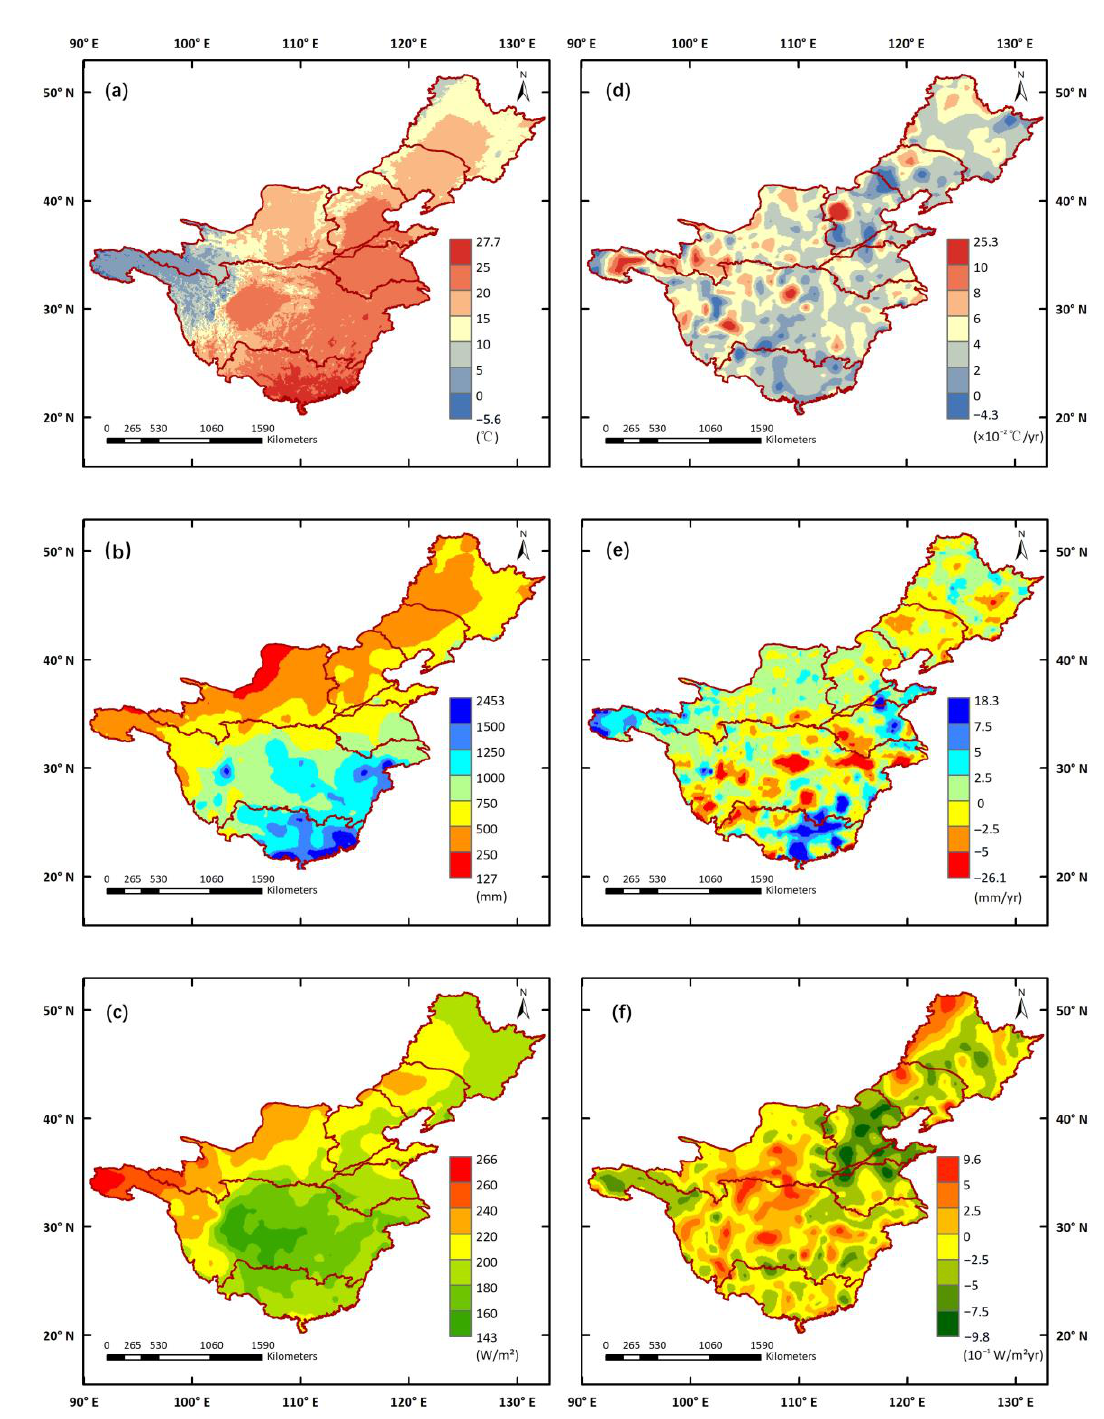
Figure 7. The spatial distribution of climate variables in seven major watersheds during 1982 – 2015: ( a ) mean annual GS-TEM, ( b ) mean annual GS-PRE, ( c ) mean annual GS-RAD, and their change trends ( d – f ).